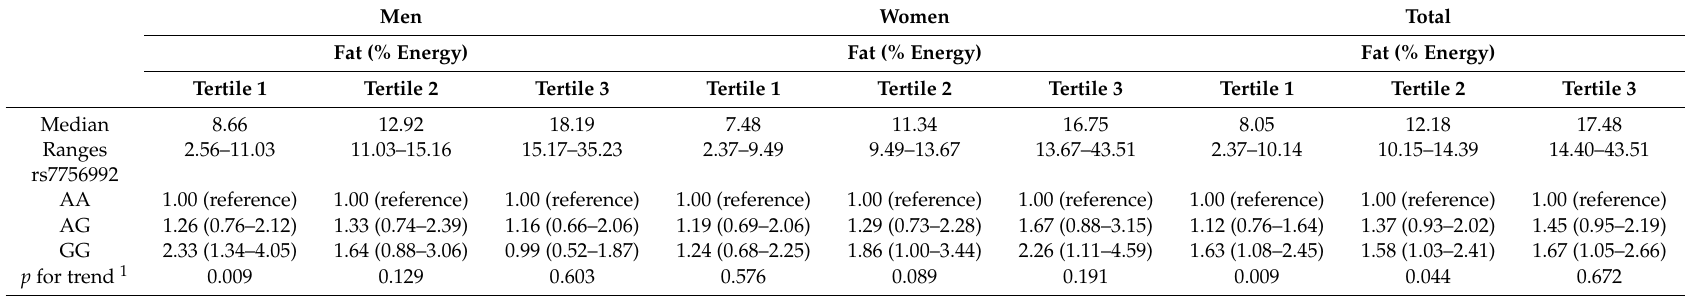
Table 4. SNP in the CDKAL1 gene and risk of diabetes by tertile of dietary fat (% energy) in Korean